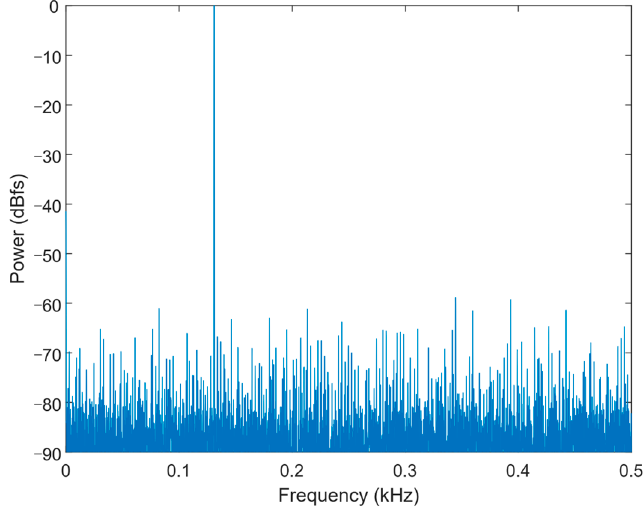
Figure 13. FFT spectrum. Table 2. Performance